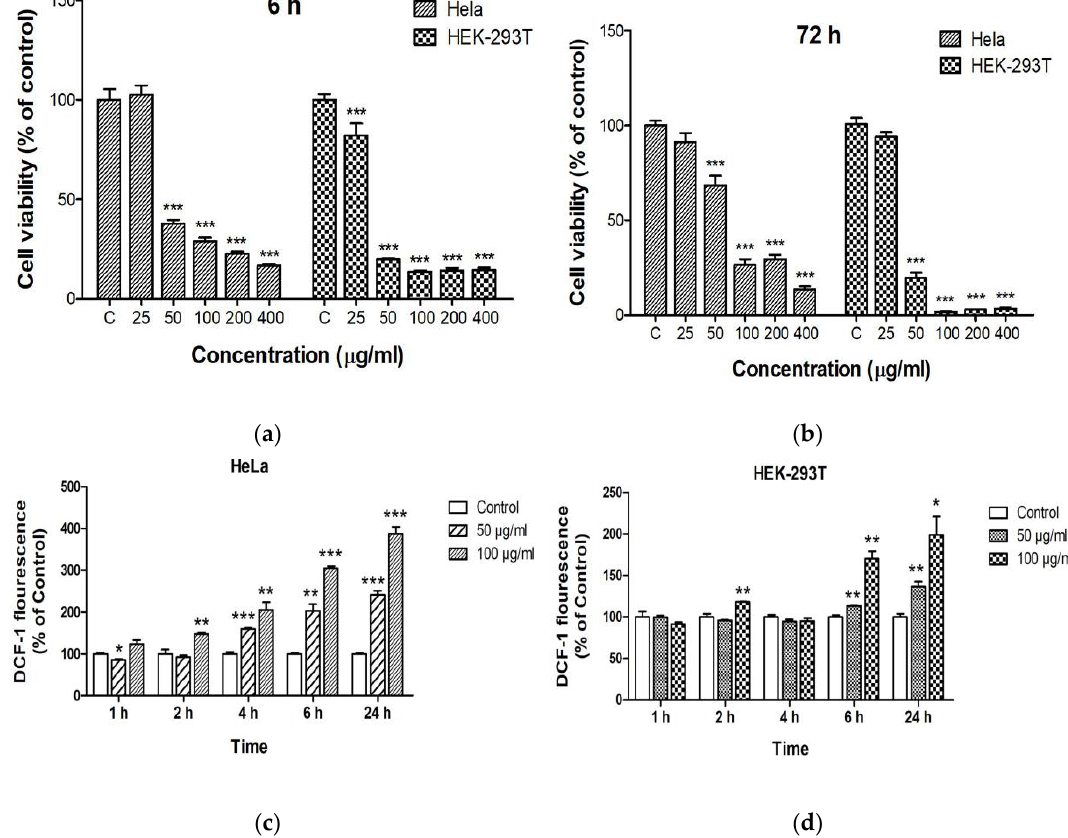
Figure 27. CCK-8 assay cell viability results for HeLa and HEK-293T cells treated with ZnO QDs at different concentrations for ( a ) 6 h and ( b ) 72 h. All data are presented as mean ± SD (n = 3). *** p < 0.001 versus control (C). ROS generation in ( c ) HeLa and ( d ) HEK-293T cells treated with ZnO QDs at doses of 50 and 100 µg/mL for 1, 2, 4, 6, and 24 h. Dichlorofluorescein (DCF) fluorescence intensity is normalized relative to control. All data are presented as mean ± SD (n = 3). * p < 0.05, ** p < 0.01 and *** p < 0.001 versus control. Reproduced from [162] under the terms of the Creative Commons Attribution